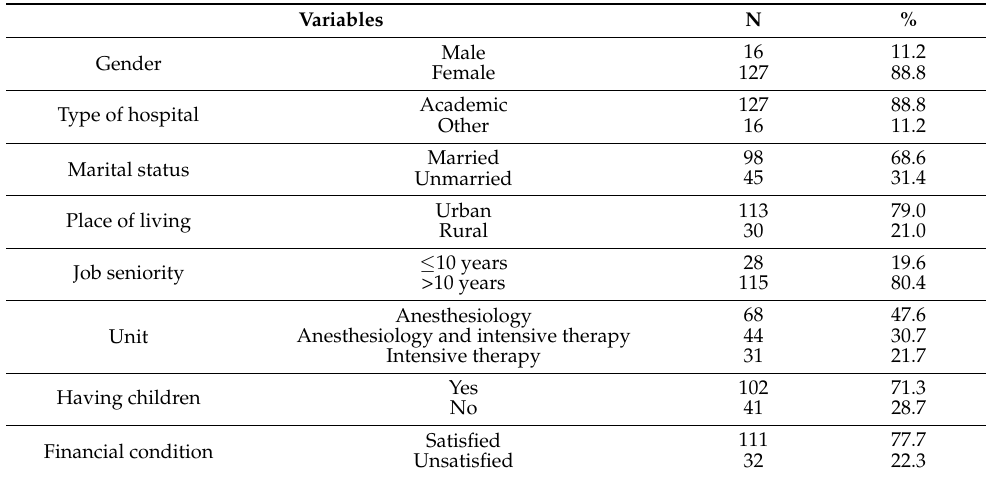
Table 1. Group characteristics ( n =